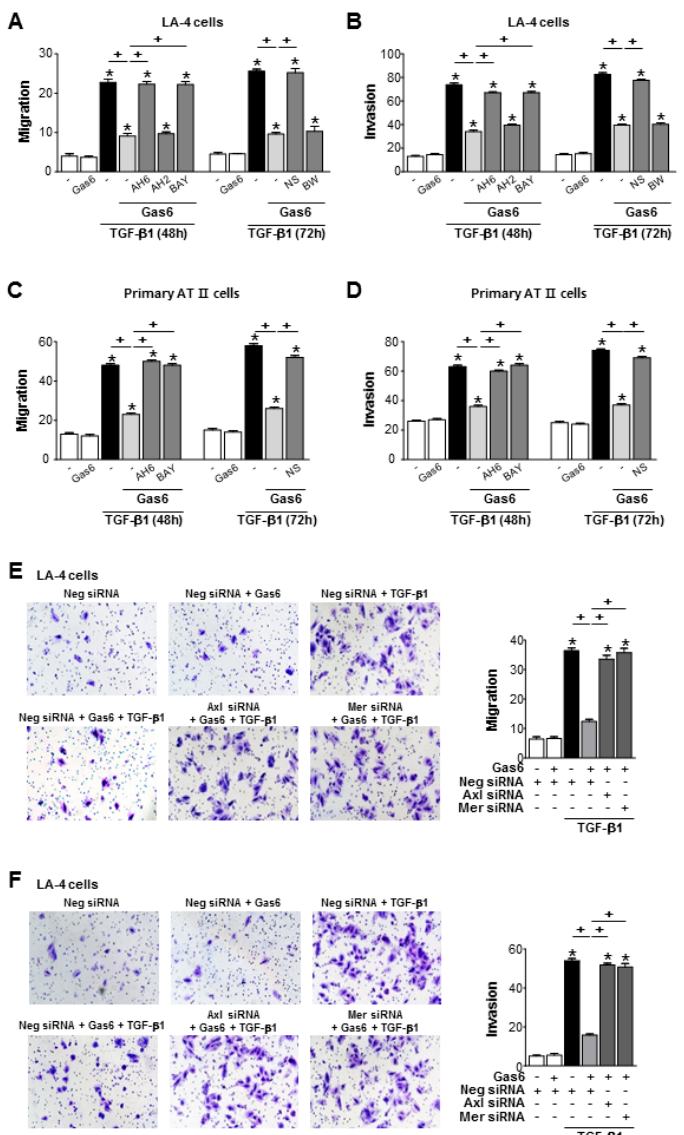
Figure 7. Growth arrest-specific protein 6 (Gas6) / Axl signaling inhibits migration and invasion of LA-4 and alveolar type II (AT II) epithelial cells (ECs) via prostaglandin (PG)E 2 and PGD 2 . ( A – D ) LA-4 and primary AT II ECs were stimulated with 400 ng/mL Gas6 for 20 h and then stimulated with 10 ng/mL TGF- β 1 with or without antagonists of EP2 (AH-6809), EP4 (AH-23848), DP1 (BW-A868C), or DP2 (BAY-u3405), each at a dose of 10 μ M, for 48 or 72 h. The quantification of migrated or invaded cells in Boyden chambers. ( E and F ) LA-4 ECs were transfected with Axl, Mer, or control siRNAs for 48 h prior to treatment with 400 ng/mL Gas6 for 20 h and then stimulated with 10 ng/mL TGF- β 1 for 72 h. The cells were visualized by phase-contrast microscopy for the analysis of migratory in ( E ) left and invasive in ( F ) left abilities using Fn-coated Transwell and Matrigel-coated Transwell plates, respectively. Scale bars: 100 μ m. Quantification of cells that migrated in ( E ) right or invaded in ( F )